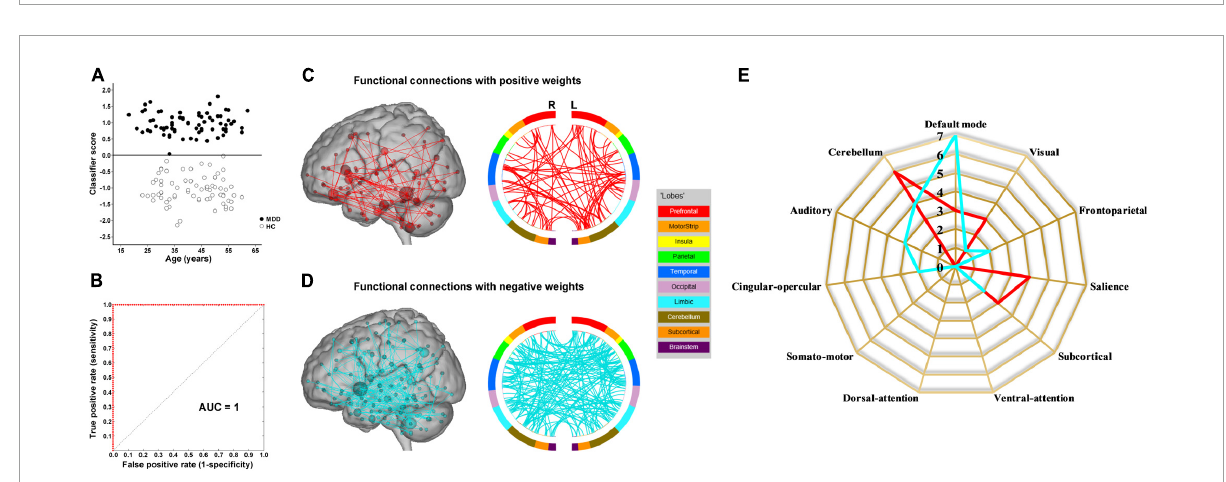
FIGURE2 Dynamic functional connectivity-based classification. (A) Scatter plot showing classification scores of all the subjects. (B) Receiver operating characteristic (ROC) curve of the classifier. (C) High-degree nodes (degree ≥ 2, larger spheres indicate nodes with higher degree) and their connections in the positive network. (D) High-degree nodes (degree ≥ 2) and their connections in the negative network. (E) Fingerprints of the 25 highest-degree nodes summarized by overlap with canonical neural